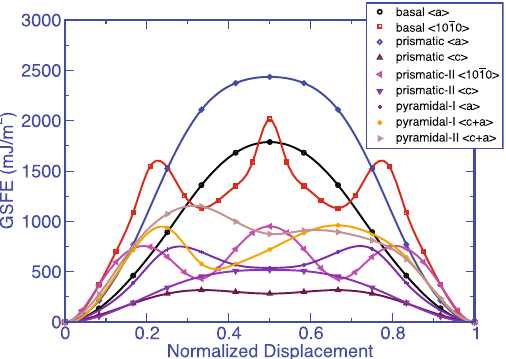
Figure 4. GSFE curves for all nine slip systems in ω -Zr obtained from the AR calculations at P = 4.9 GPa. The x-axis displacement shift corresponds to the actual displacement along the glide direction normalized by the full Burgers vectors for each slip system.